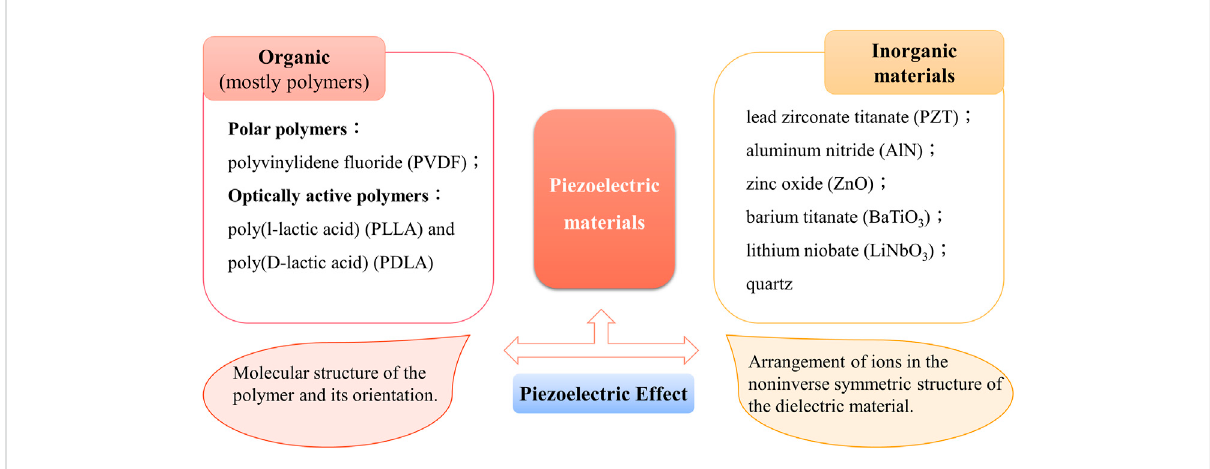
FIGURE 3 Representative materials of the piezoelectric material family and their causes of the piezoelectric effect. Piezoelectric materials are a family of organic and inorganic materials (Chorsi et al.,